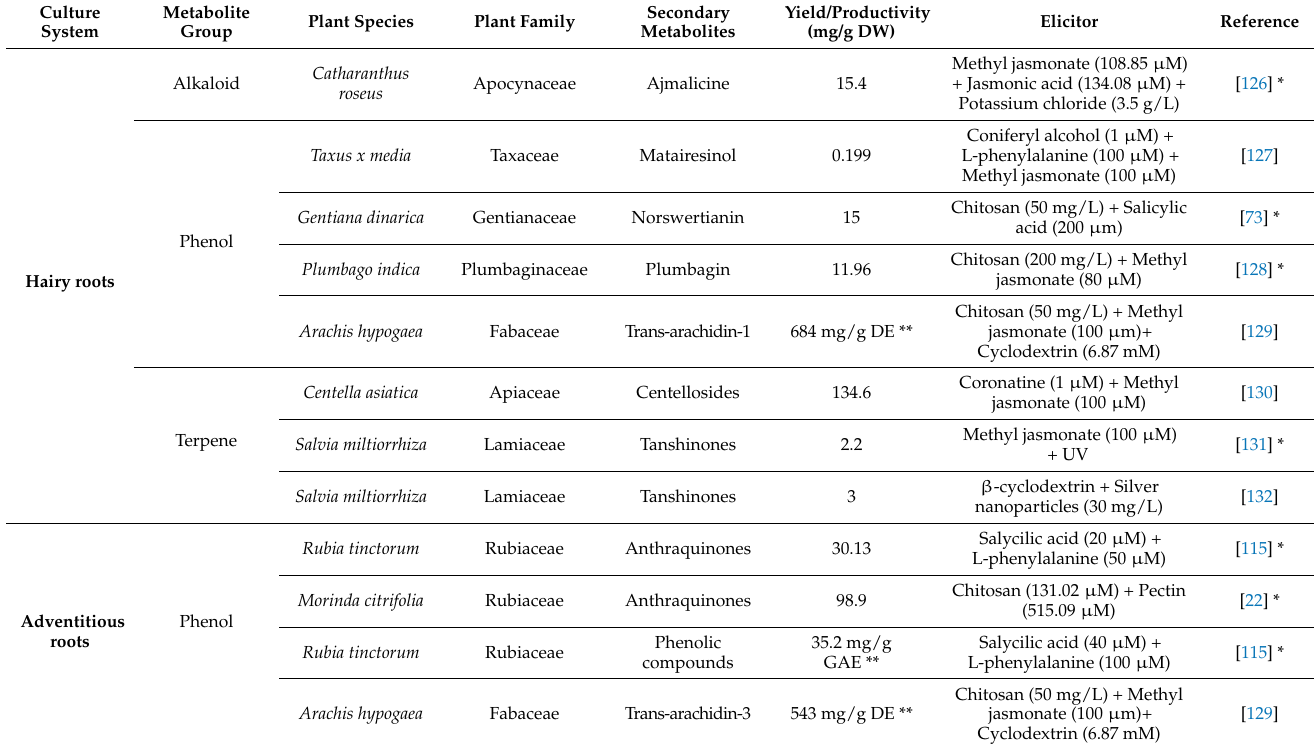
Table 3. Combined elicitation in adventitious and hairy roots from 2010 to